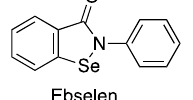
Figure 8. Chemical structure and inhibitory data of ebselen.